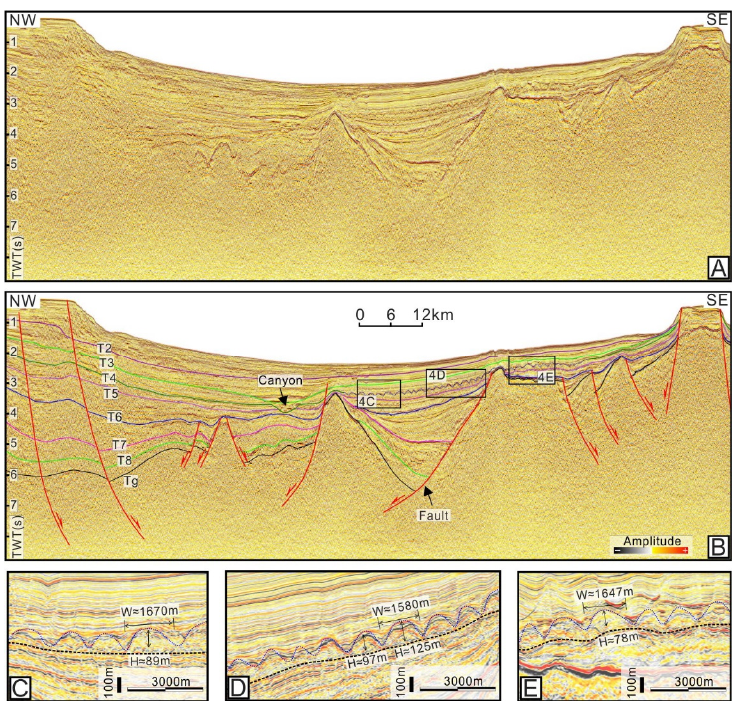
Figure 4. ( A , B ) Uninterpreted and interpreted seismic section traversing the Beijiao Sag, showing the stratigraphic and structural characteristics (for location, see Figure 1). ( C – E ) Seismic profiles and their interpretations showing the mounded topography at the top of Meishan Fm (for locations, see Figure 4A). W = width; H = height; TWT = two-way traveltime.